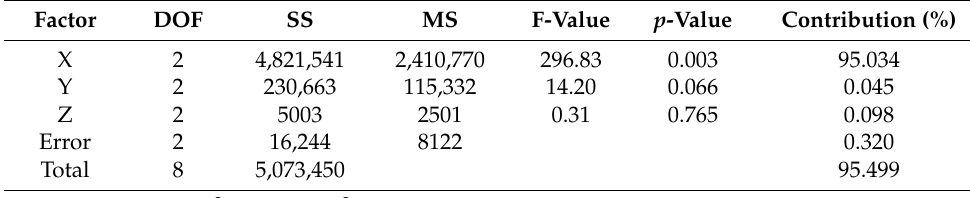
Figure 5. SN ratio graph for LOC. Table 8. ANOVA for the LOC for the MHD approach.